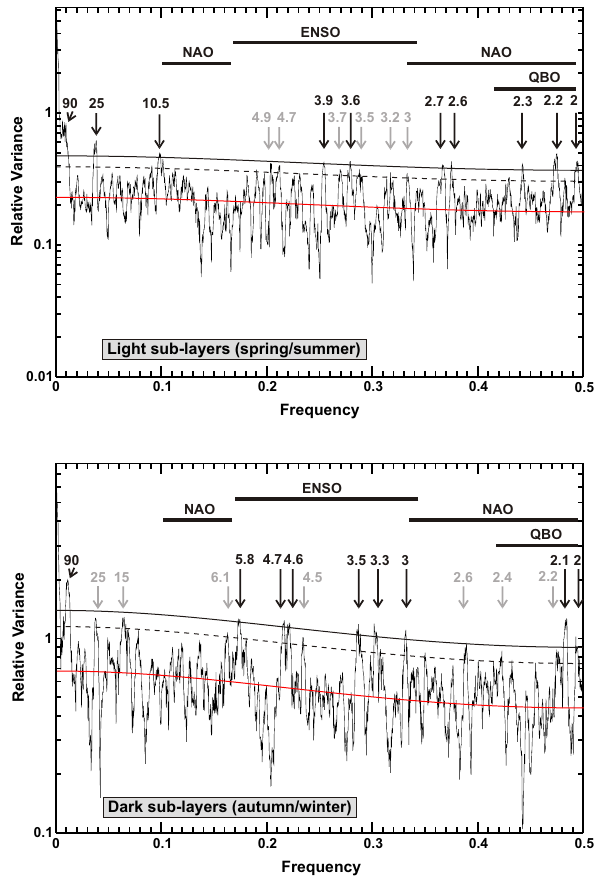
Fig. 5. Power spectra of the light and dark sub-layer thickness measurements. The red line indicates the median red noise; the dashed and solid black lines indicate the 95% and 99% confidence levels, respectively. El Ni˜no-Southern Oscillation (ENSO), North Atlantic Oscillation (NAO), and Quasi-Biennial Oscillation (QBO) bandwidths are according to Mann and Park